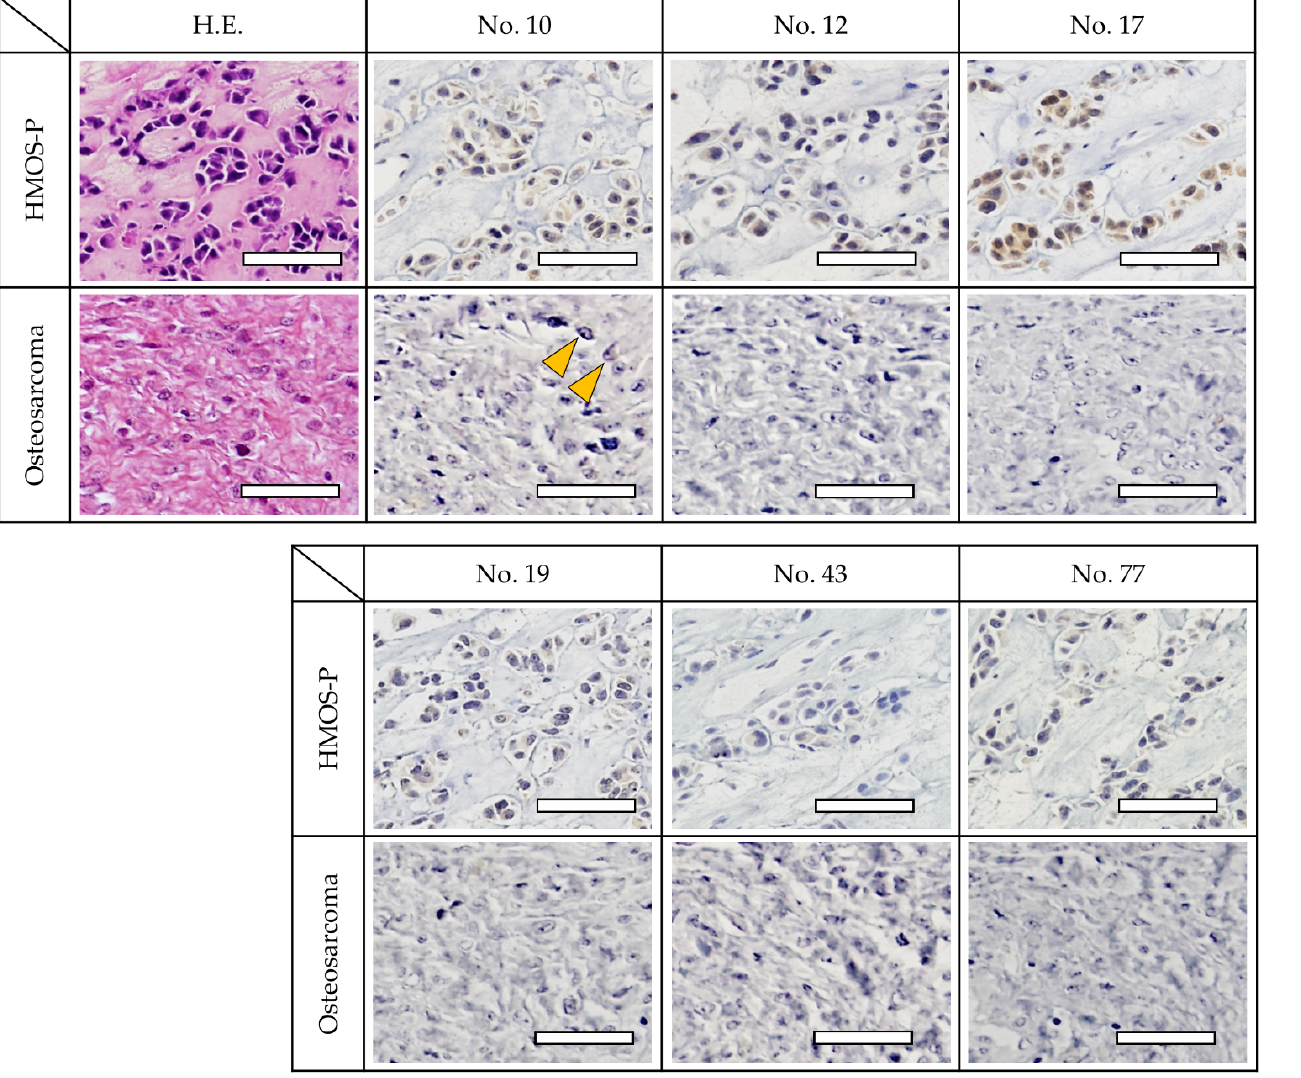
Figure 4. Immunohistochemistry of cancer tissues. Staining of similar paraffin sections of HMOS (upper row) and HOS (lower row). The cell lines exhibited strong positive staining with antibody numbers 10, 12, 17, and 77. The staining was also positive for antibody numbers 19 and 43 but relatively weaker. Immunohistochemical staining shows positive cells (yellow arrowheads). These results were comparable to those of the ELISA fluorescence intensity. Scale bar, 50 µm.